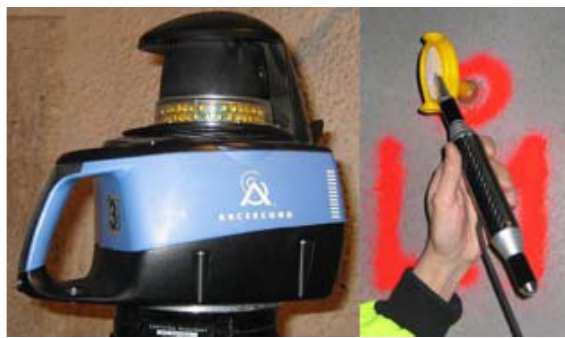
fig. 5. iGPS transmitter and sensor during a test in a tunnel